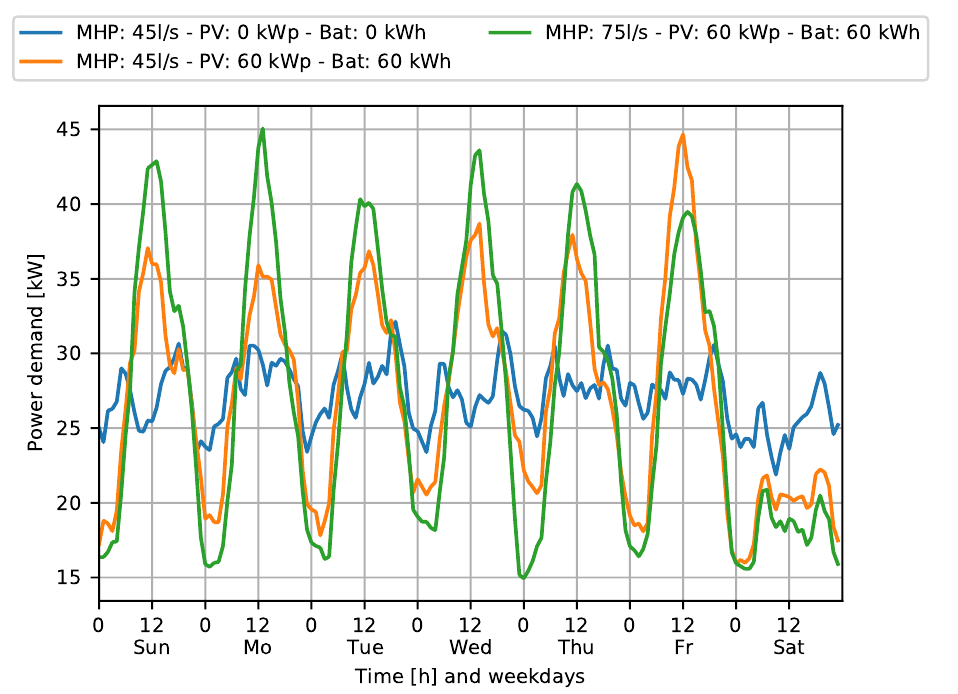
Figure 10. Average week load profile of 3 exemplary scenarios.